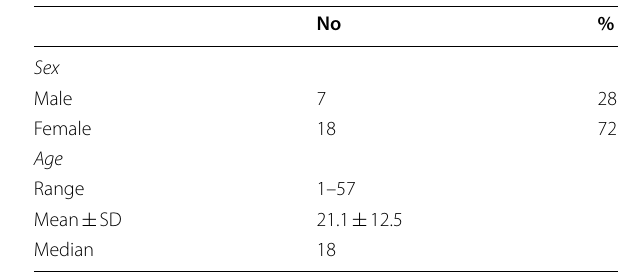
Table 1 Distribution of the studied cases according to